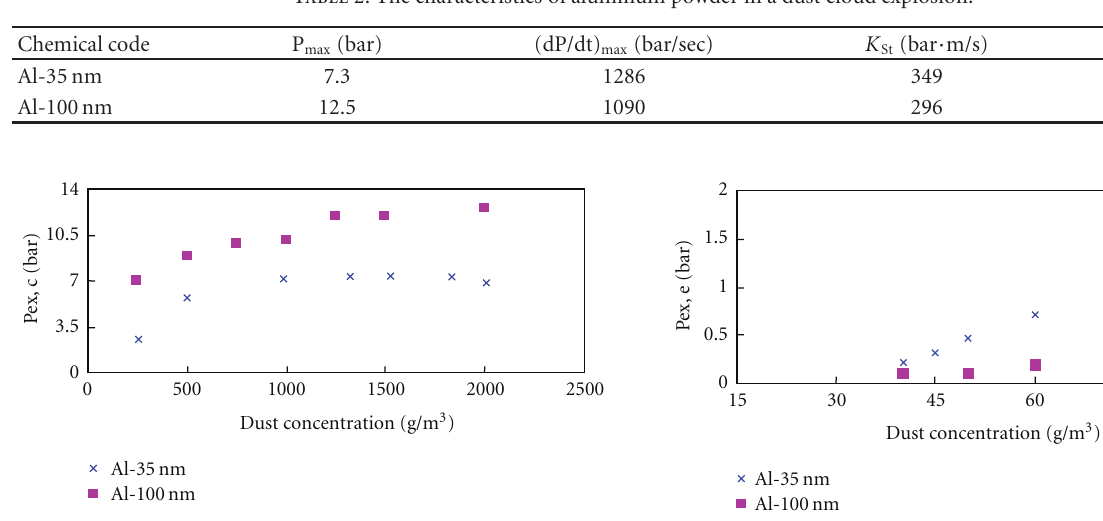
Table 2: The characteristics of aluminum powder in a dust cloud explosion.